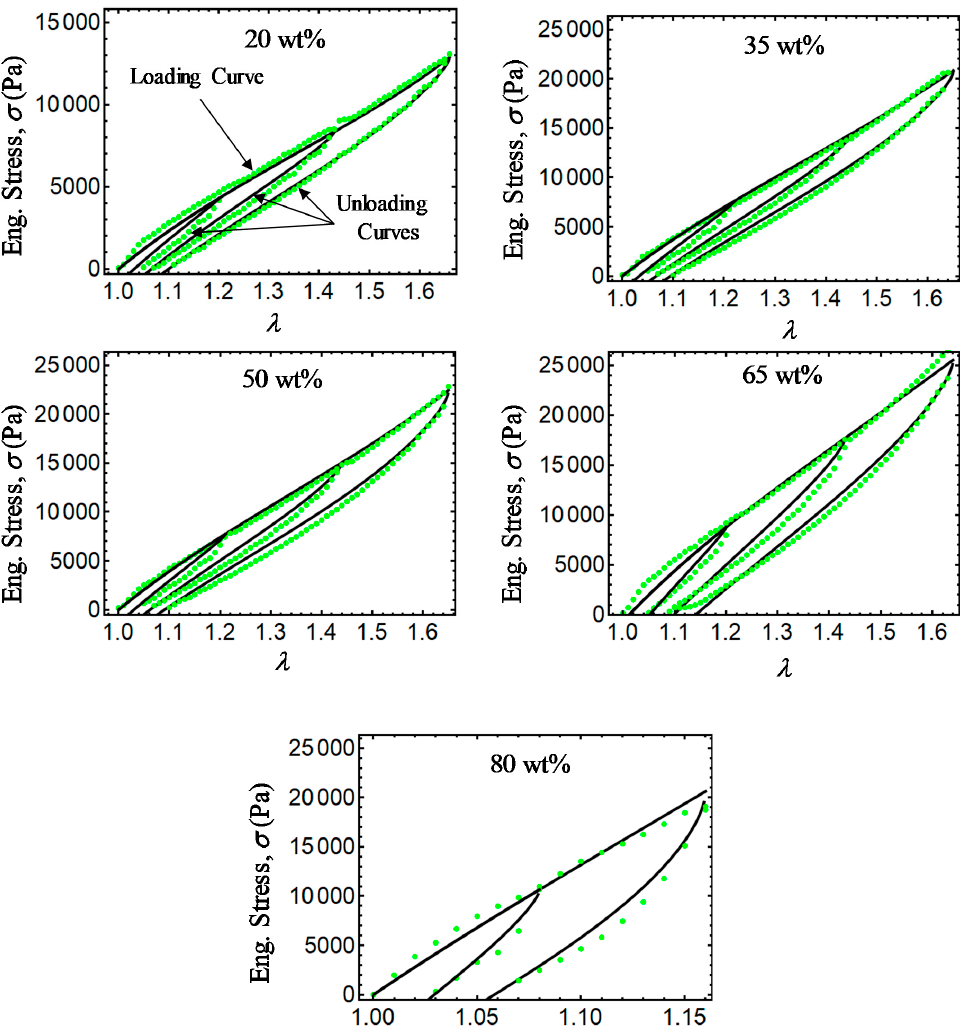
Figure 11. Engineering stress–stretch curves for isotropic magnetorheological material samples with B = 0 mT. Here, the green dots describe experimental data, while the black solid lines are theoretical predictions obtained from Equations (28) and (31).